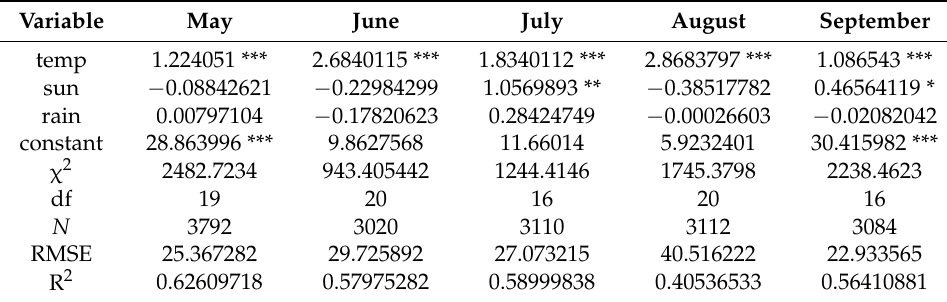
Table 2. Weather sensitivity of beverage sales, by